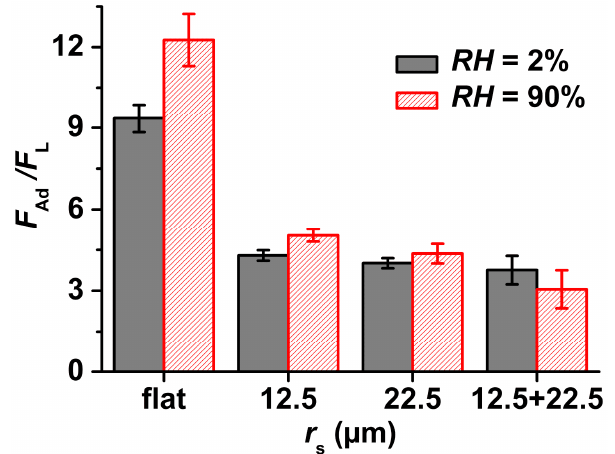
Figure 5. Average pull-off force F Ad normalized to the loading force F L = 1.0 mN ± 0.1 mN obtained on flat nanoporous PS- b -P2VP monoliths, NMMA-12.5, NMMA-22.5 and NMMA-12.5/22.5 at RH = 2% and RH = 90%. The average F Ad / F L values were obtained from at least 7 independent force-displacement measurements per sample and RH value. The error bars denote the standard deviations.